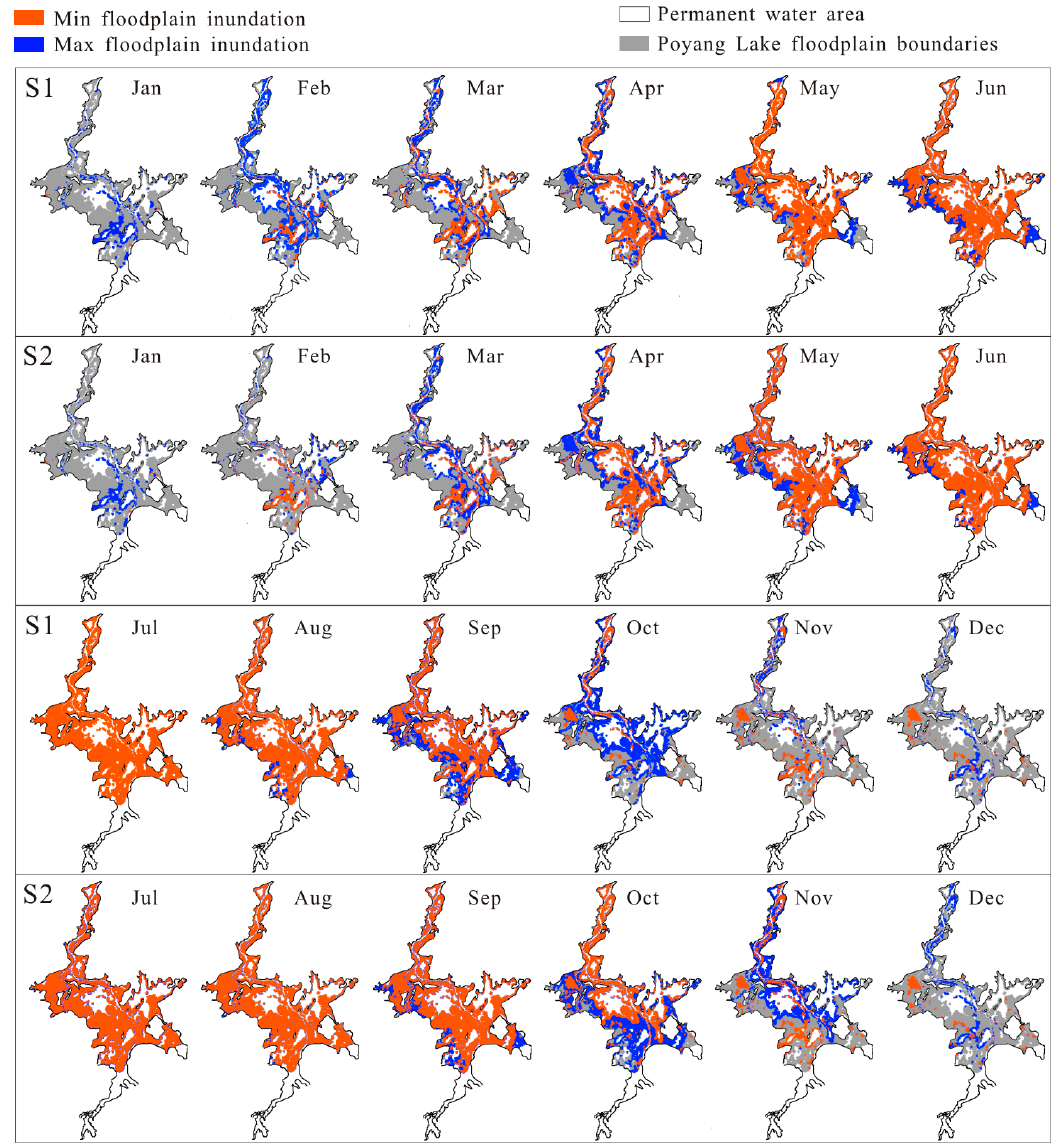
Figure 5. Monthly comparison of maximum and minimum inundation distribution in the Poyang Lake floodplains for S1 and S2. The gray area indicates the boundaries of the Poyang Lake floodplains, and the white area indicates the permanent water regions.